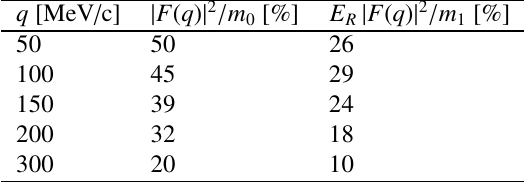
2 to m F ( q ) 0 and m 1 sum j j